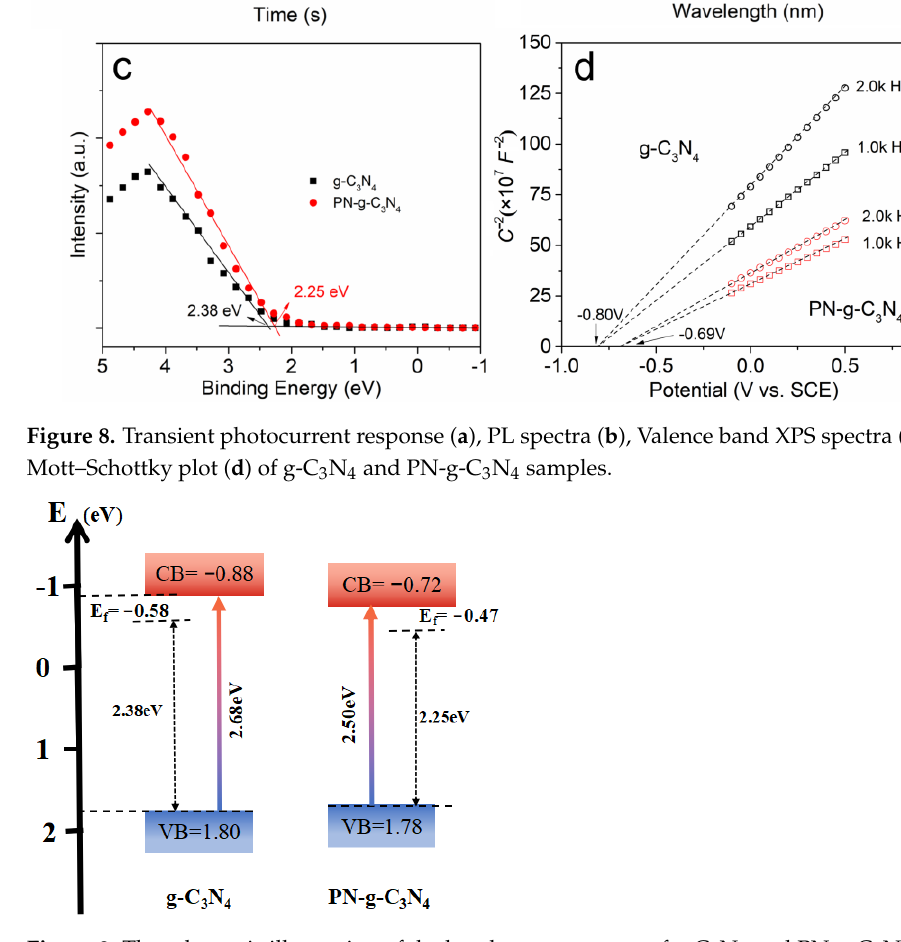
Figure 8. Transient photocurrent response ( a ), PL spectra ( b ), Valence band XPS spectra ( c ), and the Mott–Schottky plot ( d ) of g-C 3 N 4 and PN-g-C 3 N 4 samples.